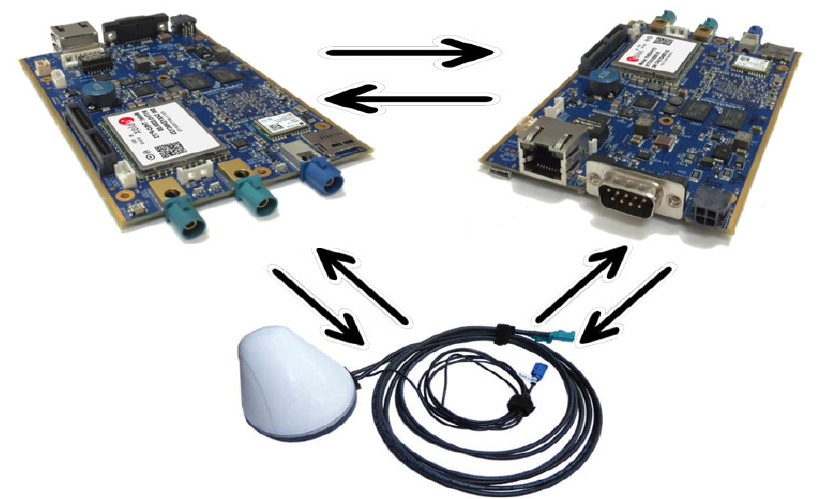
Figure 13. OBU 1 and OBU2—Antenna GPS—GNSS.